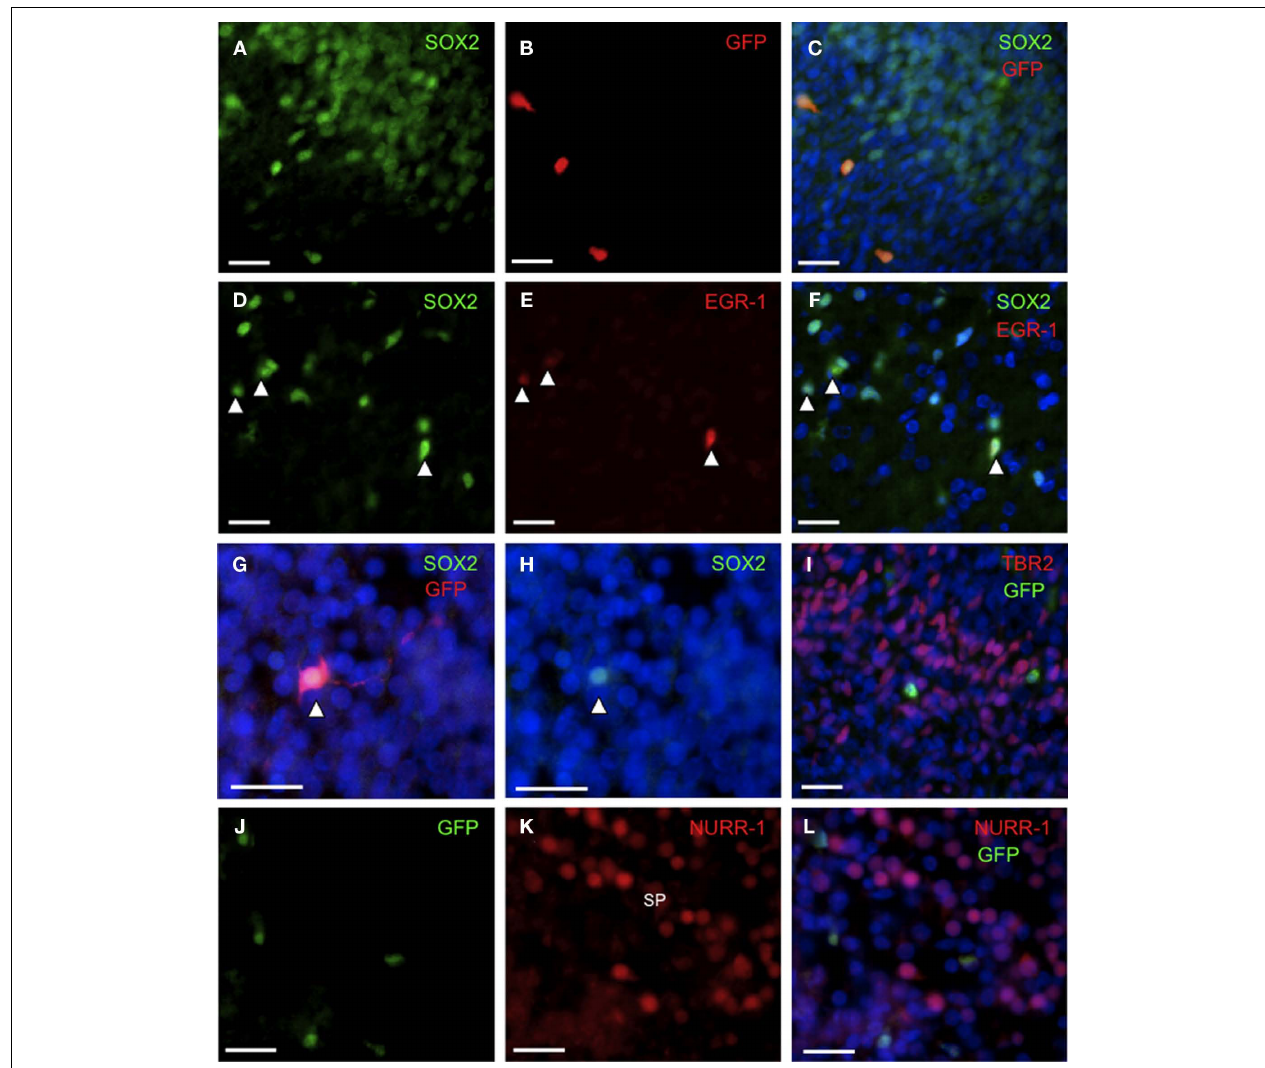
FIGURE 4 | GFP/EGR-1 co-localizes with SOX2 + cells in embryonic rat brain. Representative fluorescence microscopic images of E18 (A–F,I) and E20 (G,H,J–L) brain showing immunohistochemically detected GFP + /EGR-1 + cells in the context of total cells (DAPI, blue) and specific transcription factor proteins. (A–C) GFP is expressed in a sub-set of SOX2 +